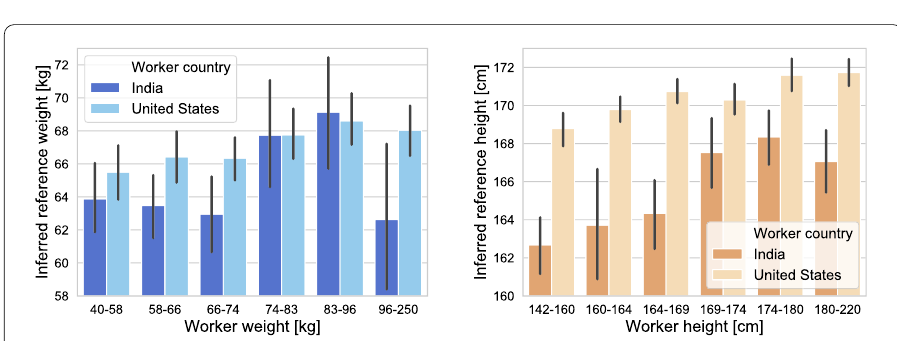
Figure 17 Dependence of weight/height reference value on worker’s weight/height and country